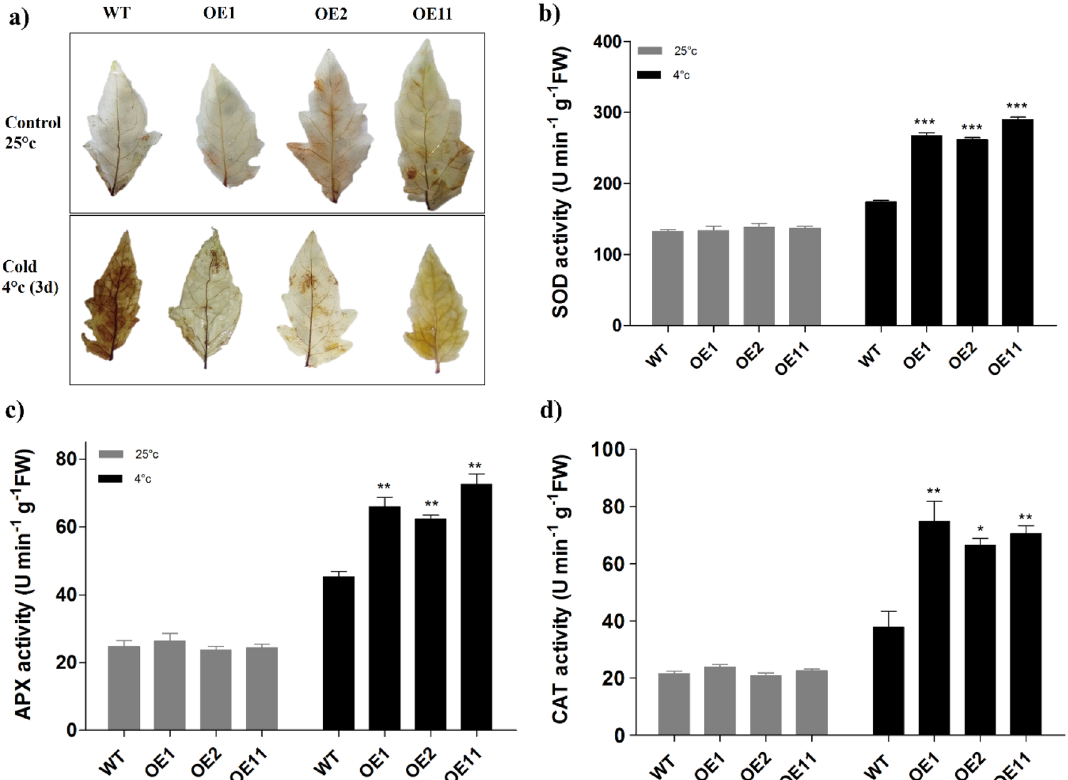
Figure 6. Comparison of ROS accumulation and antioxidant enzymatic activity in wild-type and BoCRP1 over- expressing transgenic lines under cold stress. ( a ) DAB assay of 6 week old seedlings depicting staining of H 2 O 2 with DAB in WT and transgenic leaves under Normal (25 °C) and cold stress (4 °C for 3 days). The leaflets with dark brown regions shows H 2 O 2 accumulations ( b–d ) represents the comparison of antioxidant enzyme activity of SOD, APX and CAT in wild-type and transgenic lines under both normal and cold stress. The data represents the mean of three independent biological replicate samples. The bars indicates standard deviation (SD) and asterisks represents the significant differences between wild-type and transgenic lines at * P < 0.05; ** P < 0.01; *** P < 0.001 Tukey’s Multiple Comparison